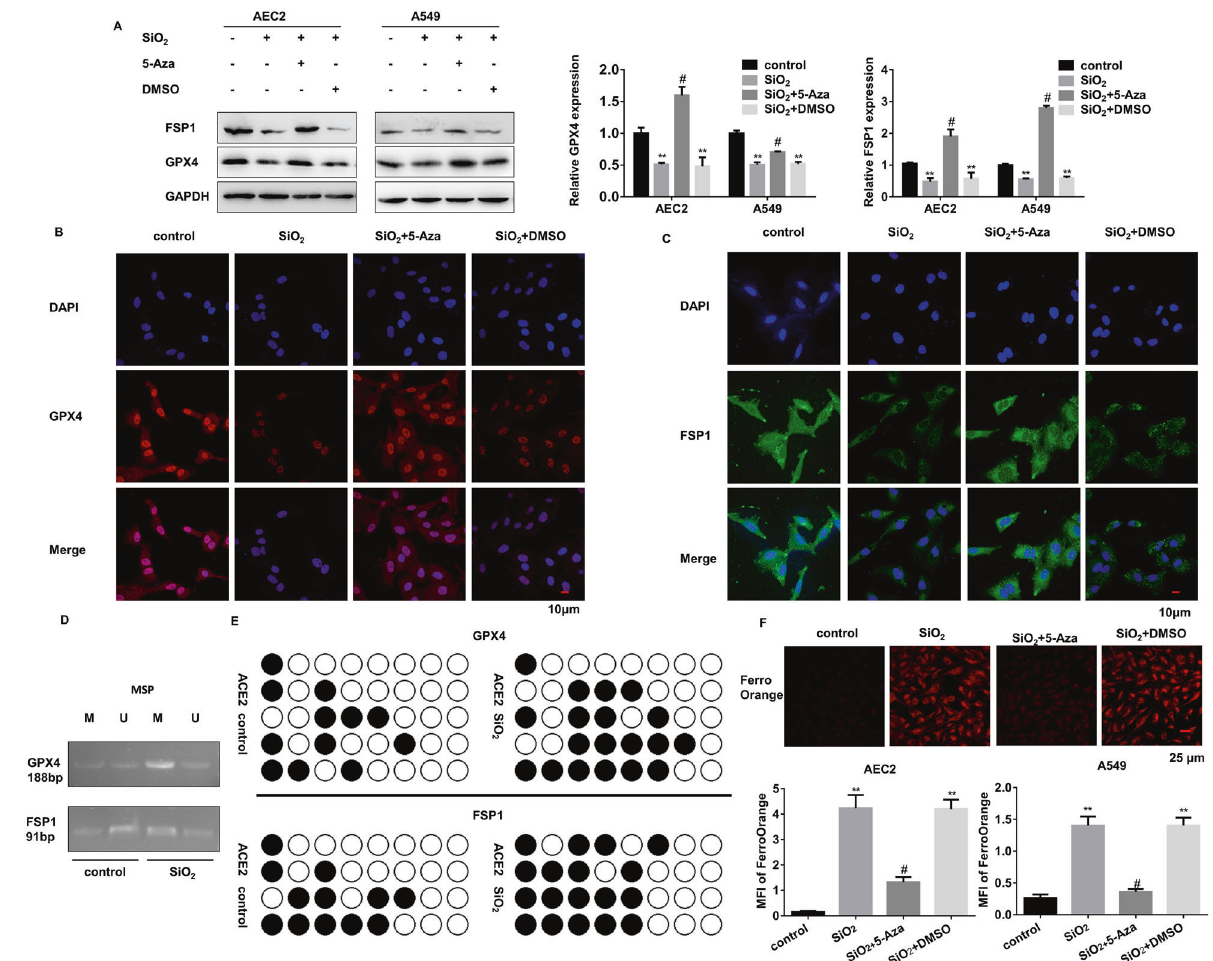
Fig. 4 DNA-methylation occurs in GPX4 and FSP1 promoter regions in SiO 2 -stimulated AEC2s. Primary AEC2 and A549 cells were treated with SiO 2 , SiO 2 + 5-Aza, and SiO 2 + DMSO. A Protein levels of GPX4 and FSP1 were detected by western blot and quali fi ed (means ± SD, n = 3) (** P < 0.01 versus control group, # P < 0.01 versus SiO 2 + DMSO group). B Representative immuno fl uorescence staining of GPX4 (red) and C FSP1 (green) in primary AEC2 cells were shown, scale bars, 10 μ m. D Methylation-speci fi c PCR detected DNA methylation levels of ACE2 cells with or without SiO 2 . E DNA from control and SiO 2 -treated AEC2 cells were subjected to bisul fi te sequencing of 5 ′ UTR. Methylated CpG sites are shown with black circles and unmethylated sites with open circles. F Intracellular Fe 2 + was detected with the FerroOrange probe, and representative images of primary AEC2 cells were shown (red: FerroOrange-stained Fe 2 + ; scale bars, 25 µm; upper panel). Fe 2 + fl uorescence intensity was quanti fi ed by ImageJ in both primary AEC2 and A549 cells (** P < 0.01 versus control group, # P < 0.01 versus SiO 2 + DMSO group; lower